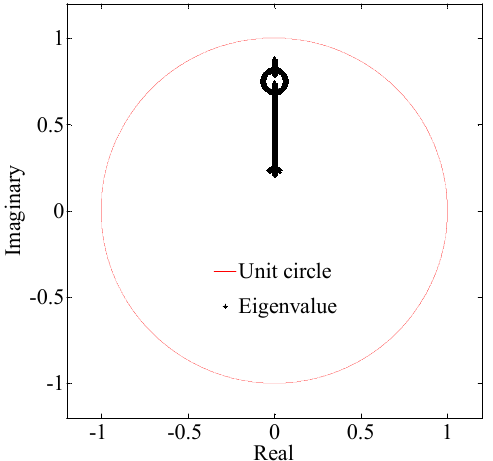
Figure 2. Relationship between the eigenvalues of A − BK mpc ( S x + I c C ) and unit circle in the complex plane.